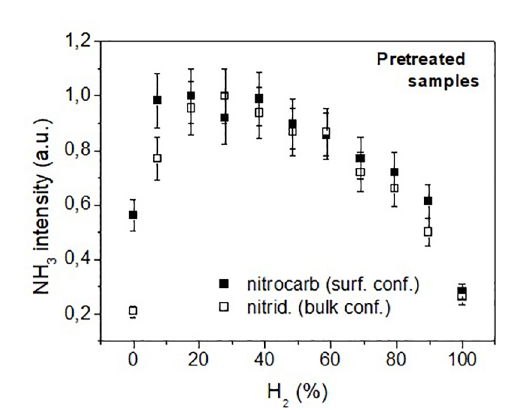
Figure 9. Evolution of the ammonia ion peak (NH during nitriding (bulk configuration) and nitrocarburizing (surface configuration) process using a pretreated sample